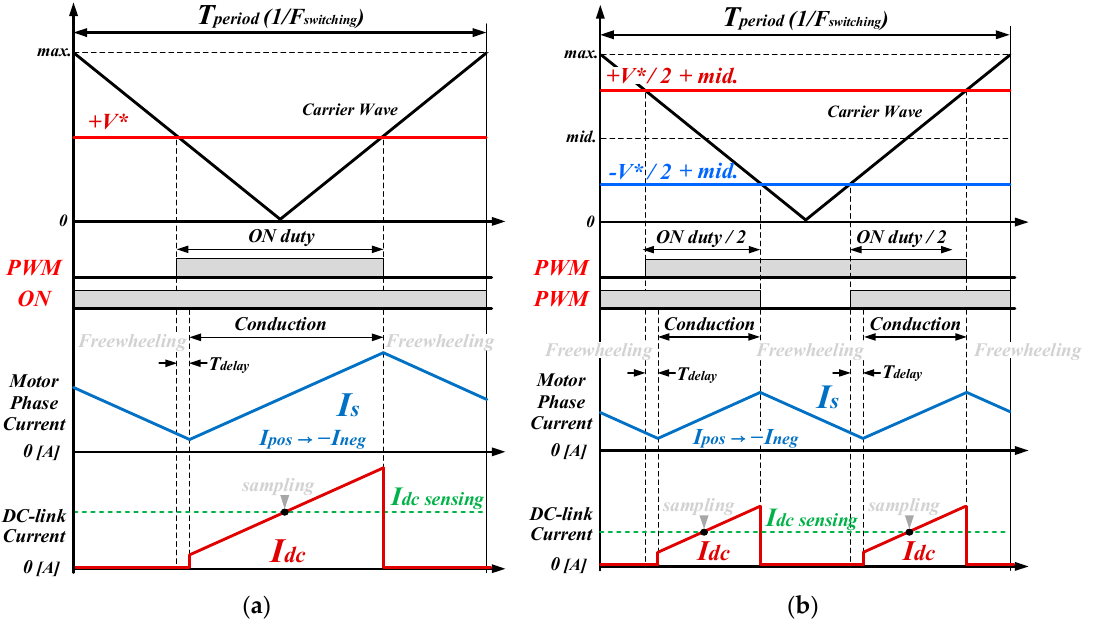
Figure 4. PWM pattern and waveform of phase and DC-link current determined via PWM: ( a ) Other unipolar PWM methods; and ( b ) H-PWM-L-PWM method.